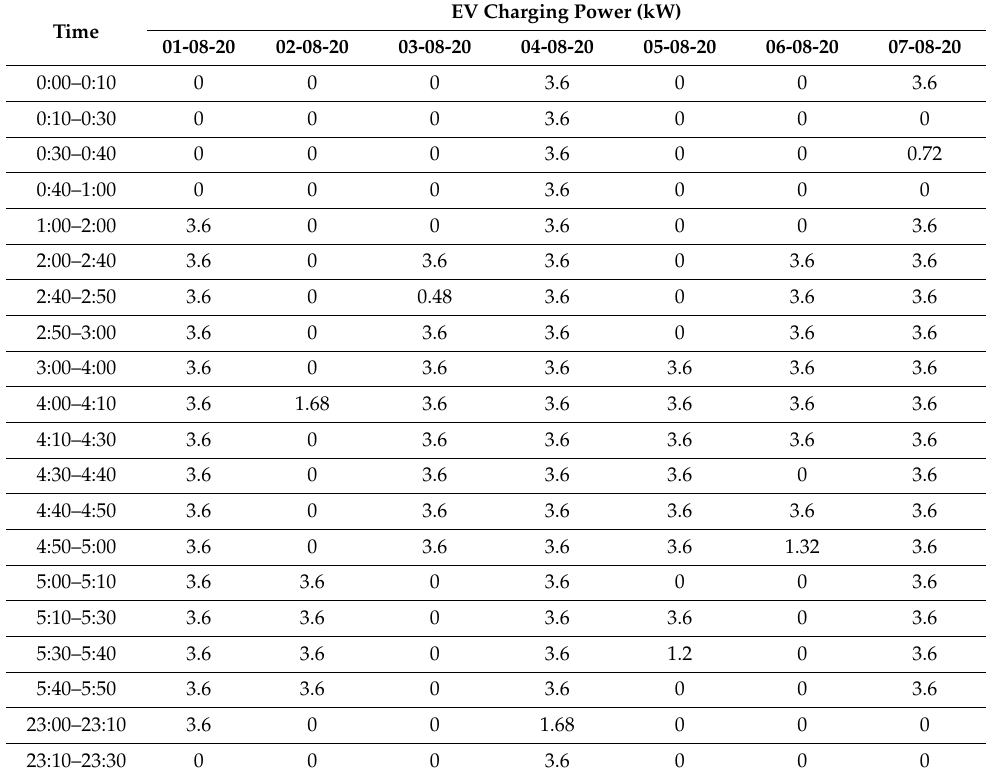
Table A2. EV charging power in